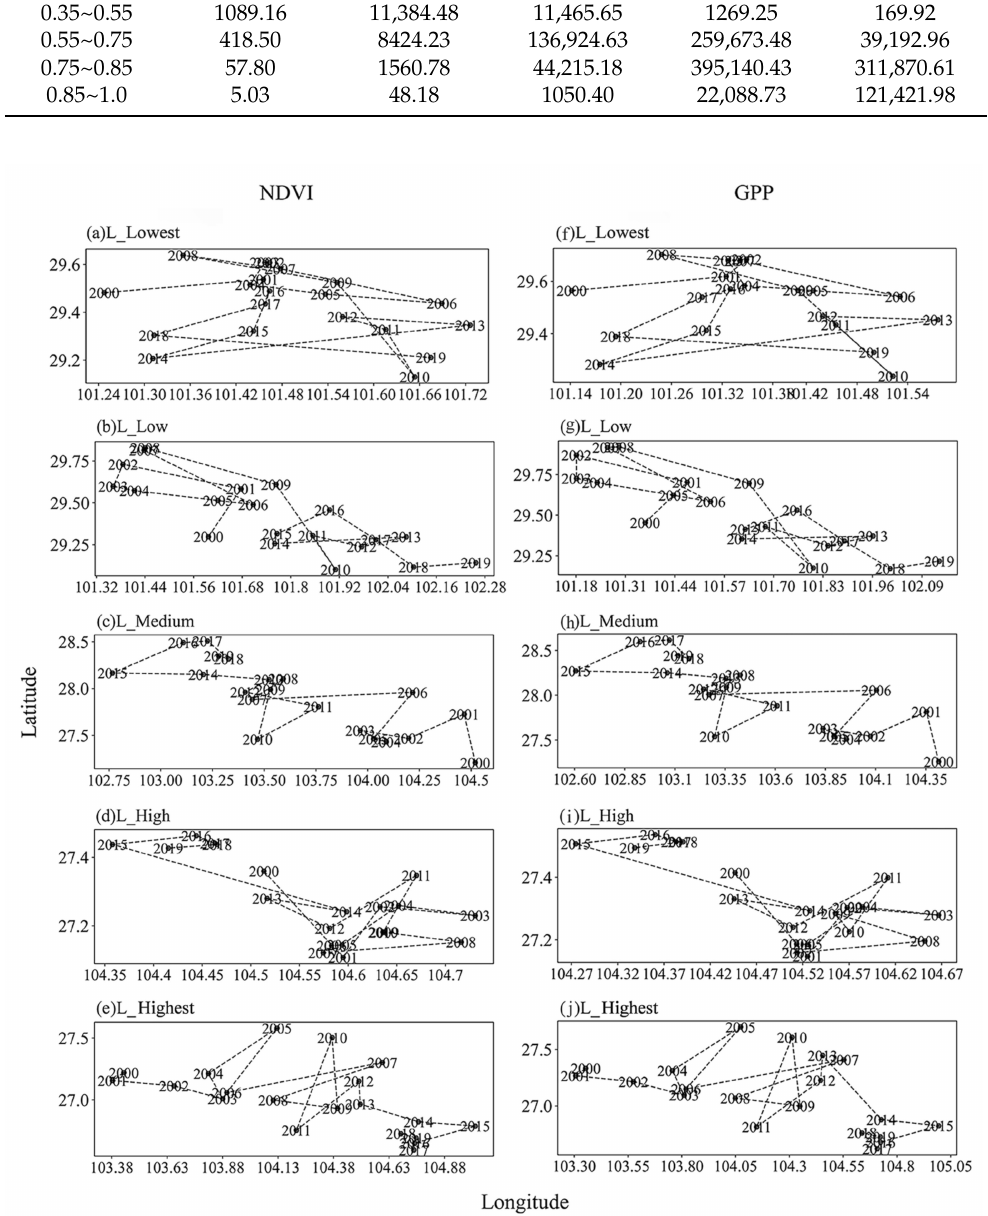
Figure A1. Variation in the center of gravity of different NDVI grades and its GPP. (Note: ( a – e ): Changes in the center of gravity of the five NDVI grades from 2000 to 2019; ( f – j ): Changes in the center of gravity of GPP for five NDVI grades from 2000 to